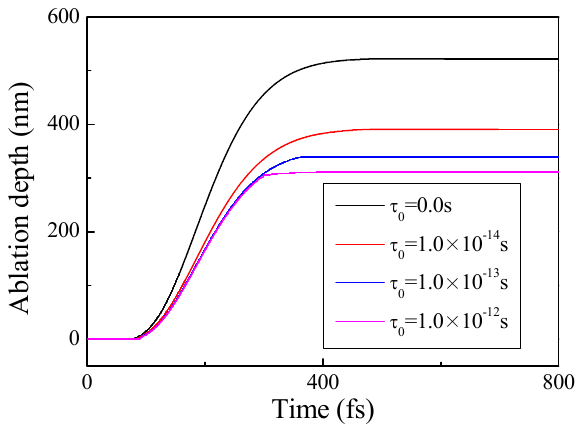
Figure 6. The ablation depths vary with time at different relaxation times ( F fluence = 10 J/cm 2 ).